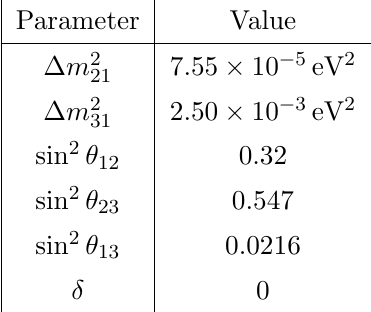
Table 1 . The standard neutrino oscillation parameters used in the analysis, taken from ref. [1], except for (cid:14) which is set to zero for